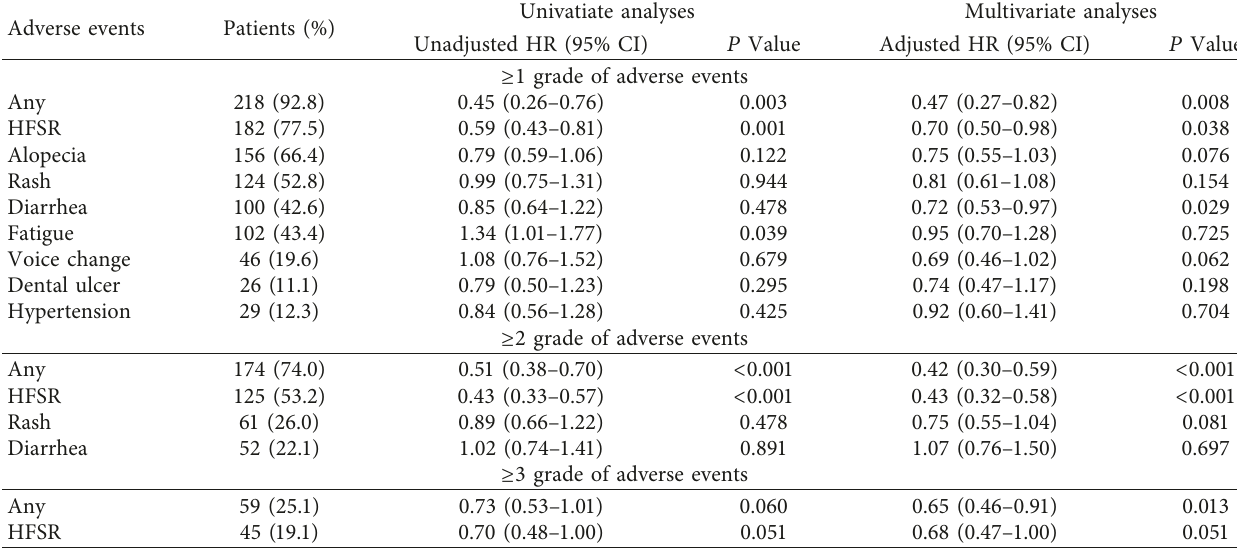
Table 4: Univariate and multivariate analyses of different type of adverse events for overall survival. Adverse events